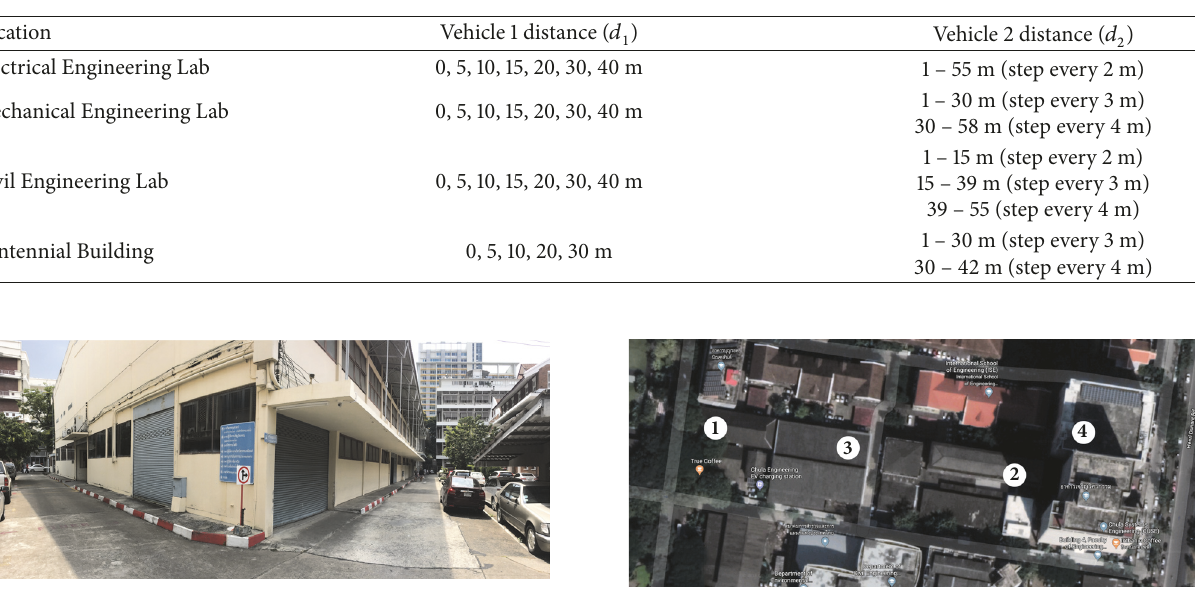
Table 3: Experiment distance for each blind corner.